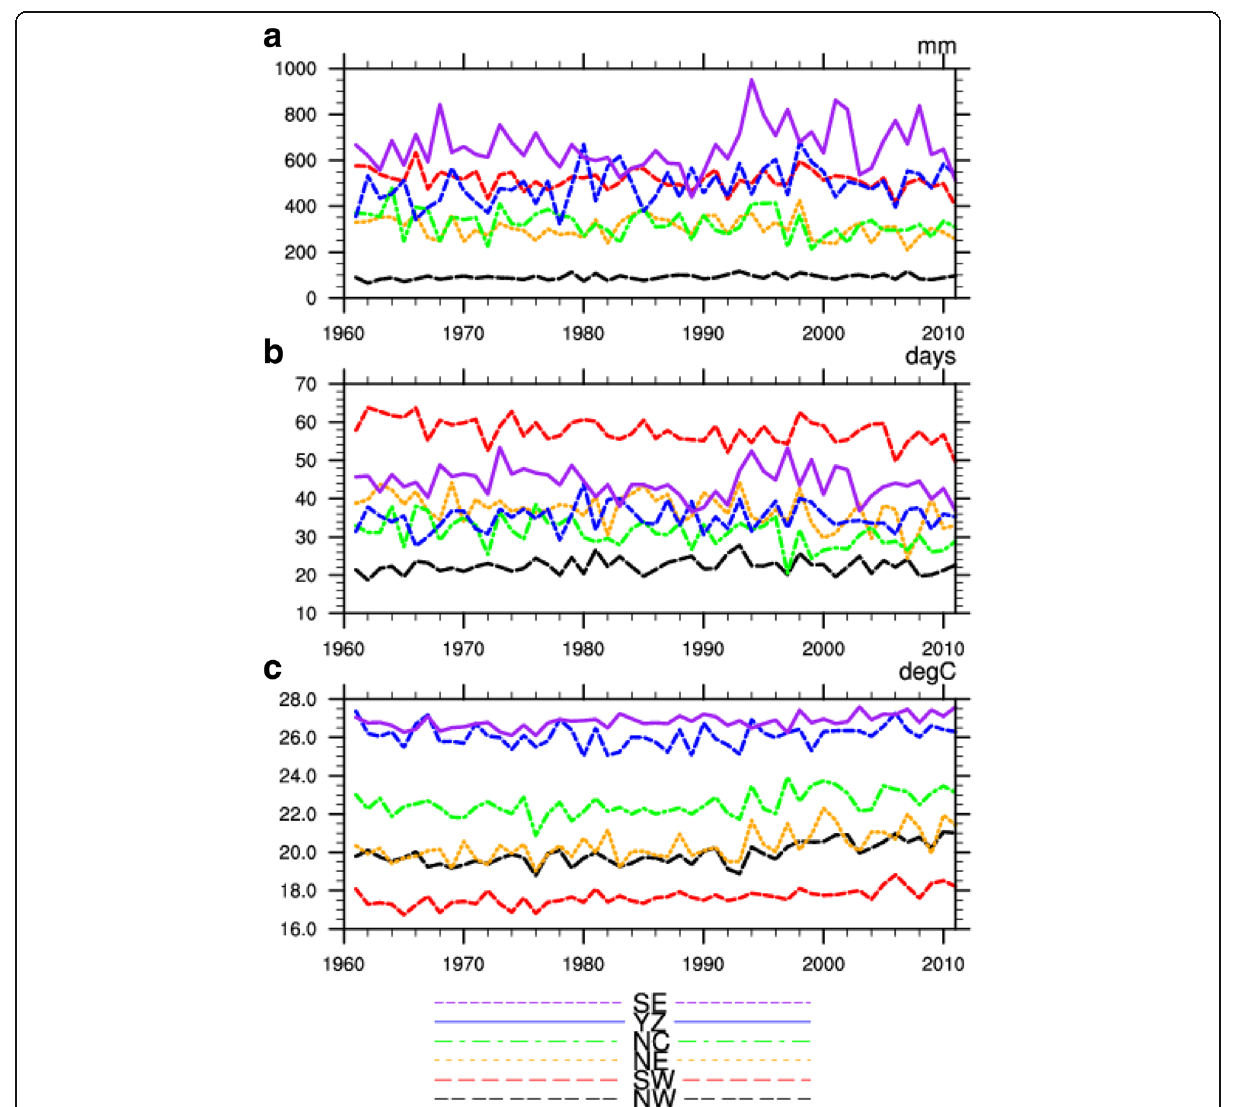
Fig. 3 Subregional climate changes from 1961 to 2011 in summer a rainfall amount, b rainfall days, and c